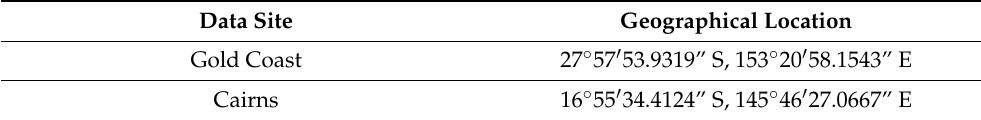
Table 1. Geographical location of data site.